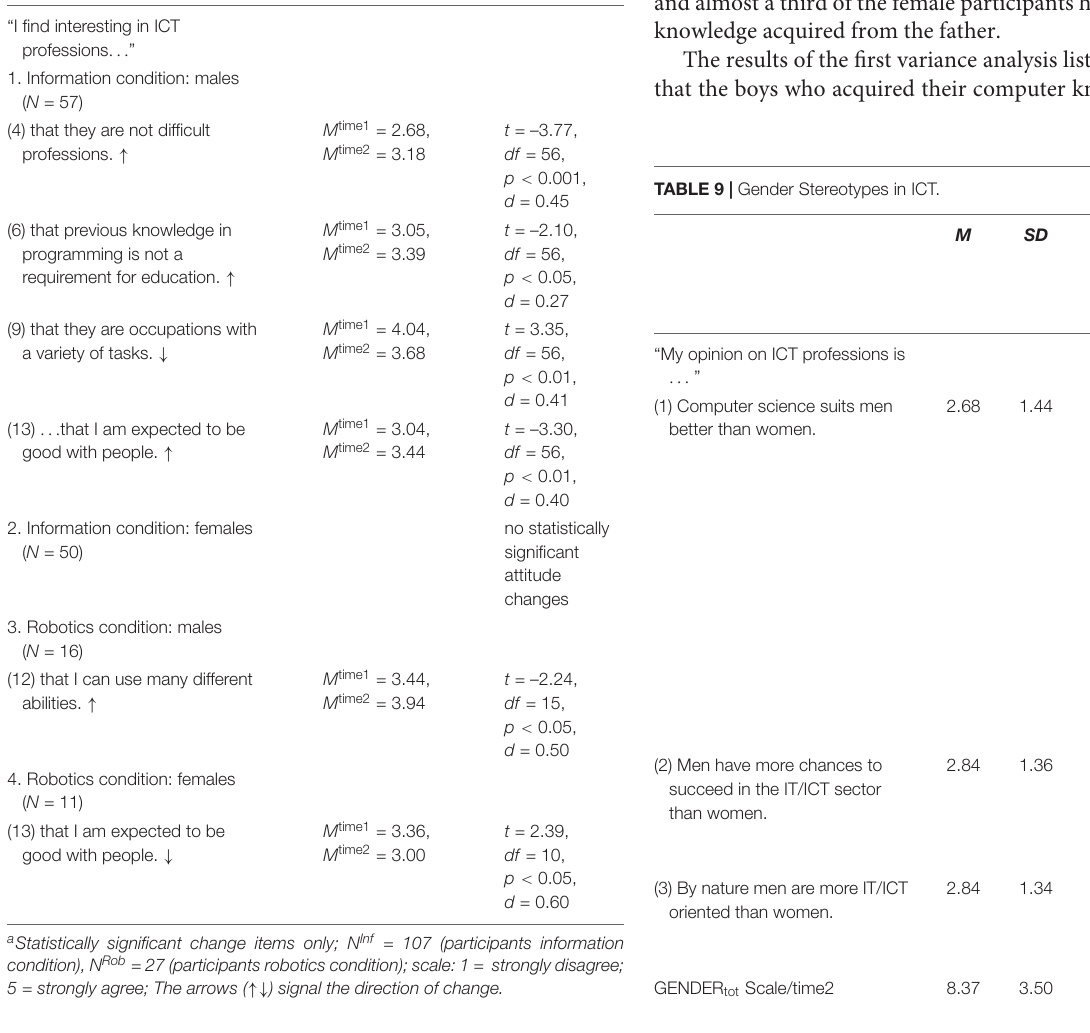
M time1 M time2 Paired t -test results